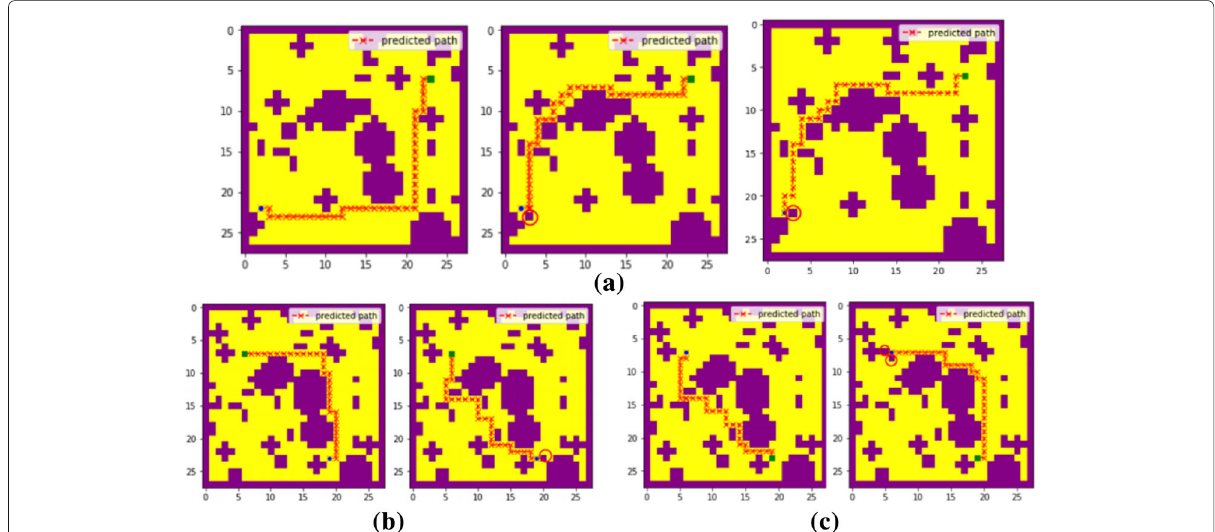
Fig. 3 An illustration of the interference effect before and after adding adversarial points when the path size is 2. We show two types of maps here, where ( a ) denotes the first type, and ( b ), ( c ) all belong to the second